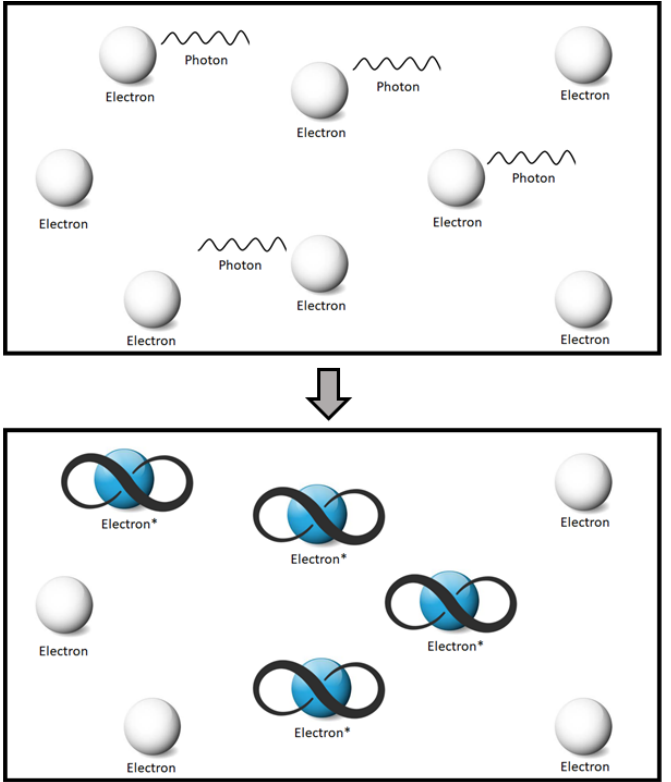
Figure 1. The phenomenon of the absorption of photons’ energy by the electrons in nano-structured solid state of matter within a closed system, where they may theoretically stay in this condition for extremely long periods of time